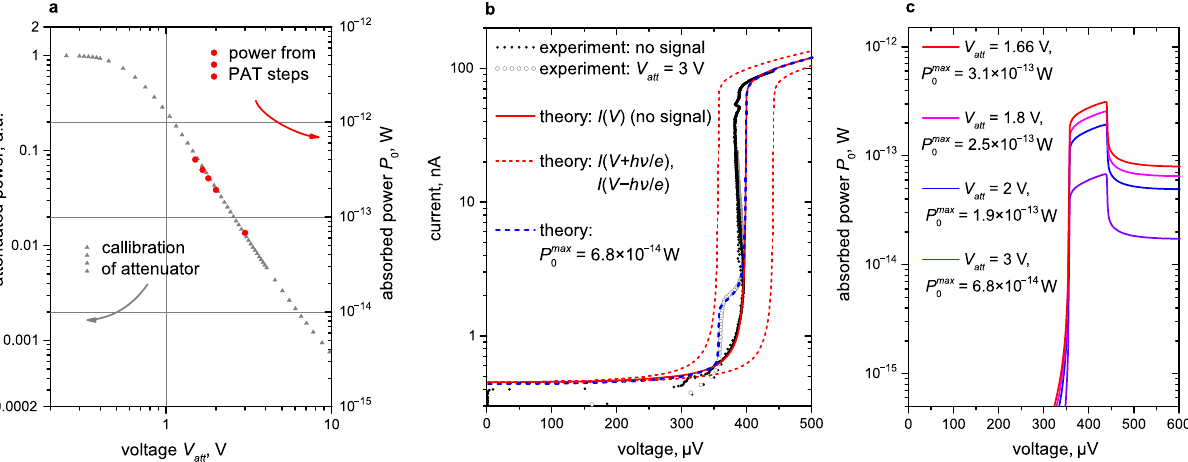
Fig. 4 Determination of absorbed power from PAT steps. a The output power through the variable attenuator versus the attenuator voltage. b An example of obtaining a PAT step from the IVC using Eq. (9) and fi tting an experimental I – V characteristics. c The power absorbed in the SIS junction for the attenuator voltages from 1.66 V to 3